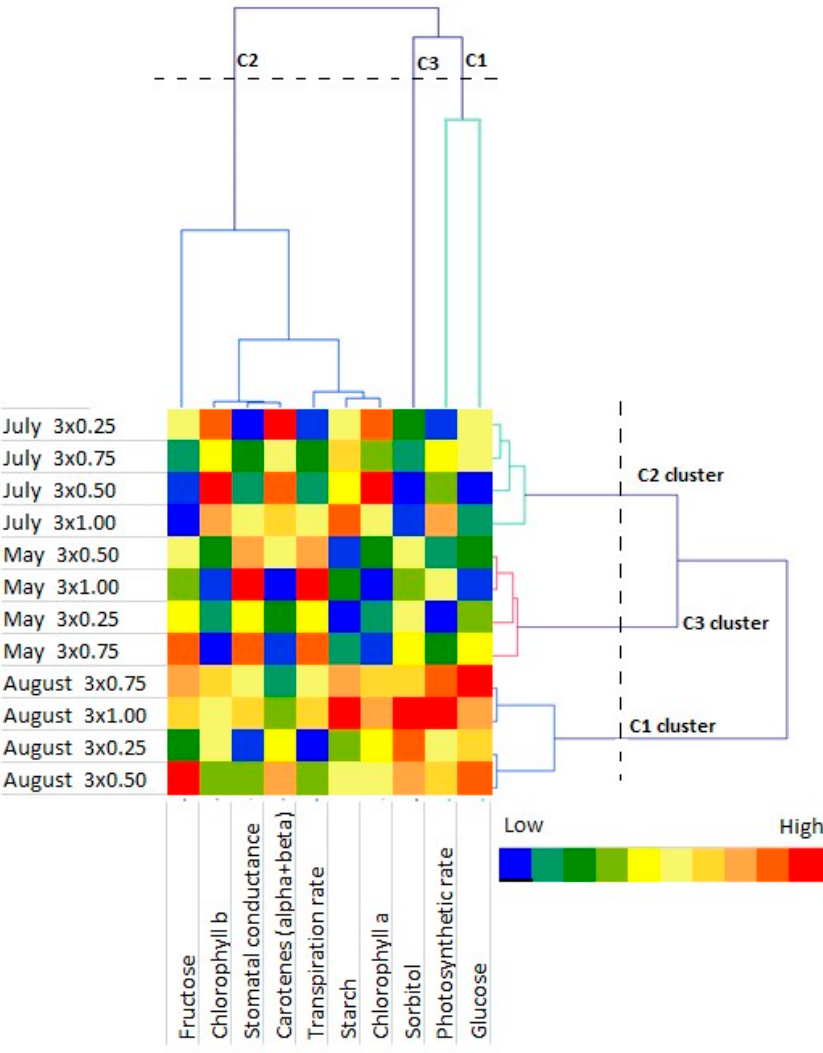
Figure 9. Agglomerative hierarchical cluster (AHC) analysis in stomatal conductance, photosynthetic rate transpiration rate, photosynthetic pigments, soluble sugars and total starch grouped by similarities in concentration mean and intensity values.